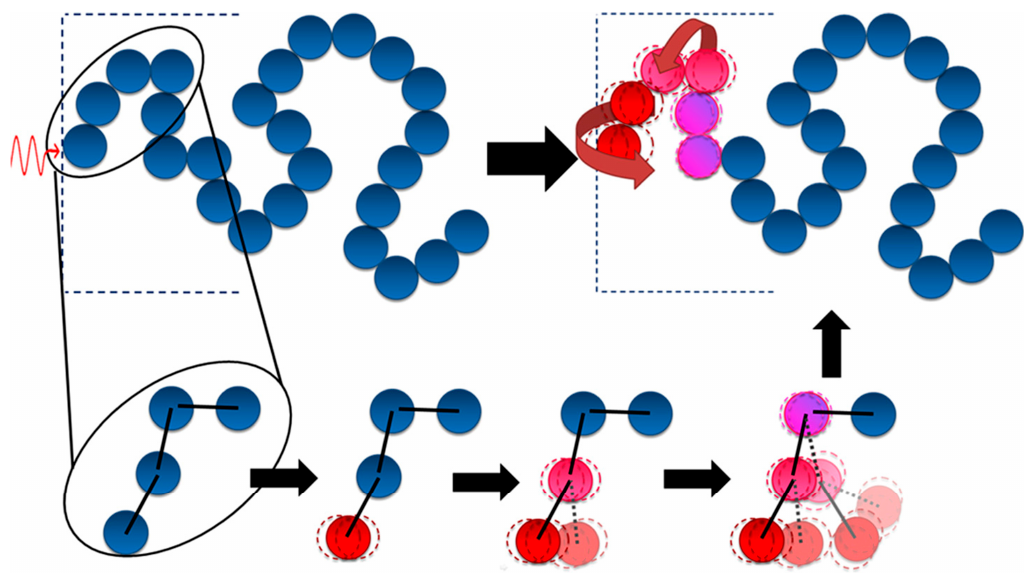
Figure 2. Schematic of thermal conductive mechanisms in polymer [29]. Copyright (2016), with permission from Elsevier.